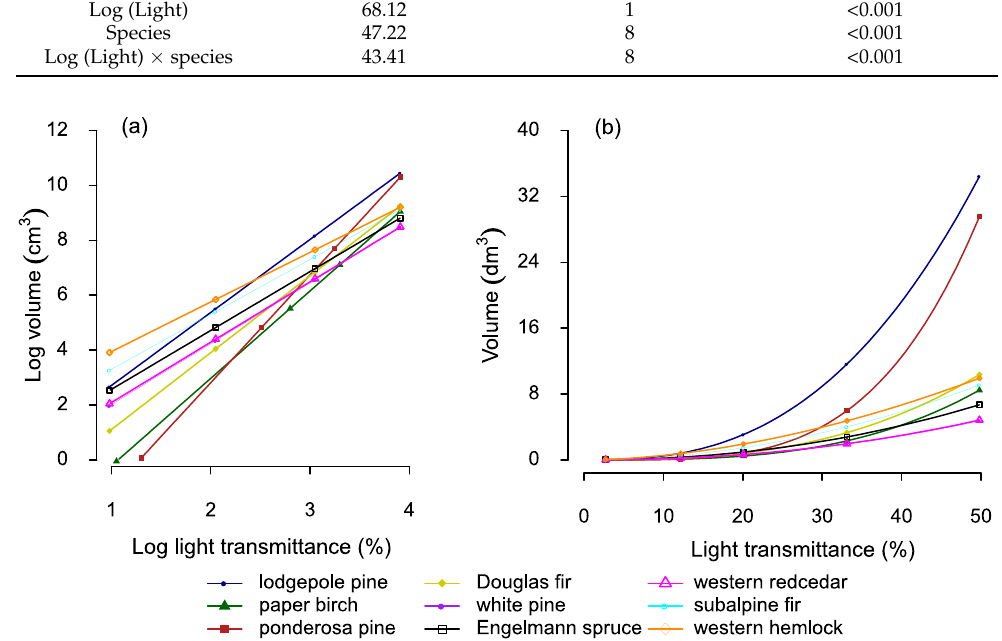
Figure 3. Growth responses of 9 species to the light gradient on a log-log scale ( a ), and back-transformed to original units for light and volume ( b ). Plots for individual species with their corresponding data points are shown in Figure A1.